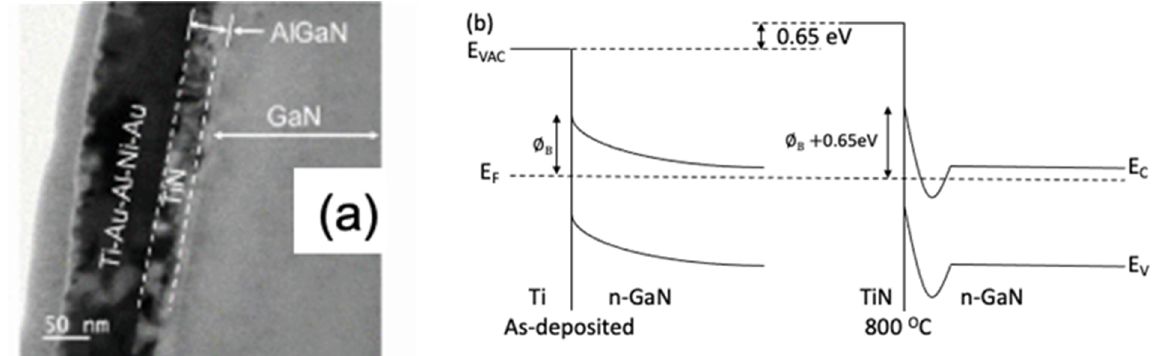
Figure 9. ( a ) TEM images of Ti/Au/Al/Ni/Au structure after alloying [63] , and ( b ) band diagram before/after alloying [65] . Figure reproduced with permission from IEEE Electron Device Lett. & AIP Publishing.